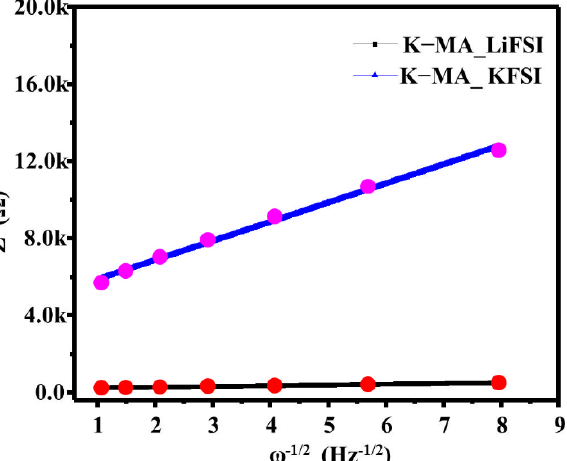
Figure 2. Ion diffusion coefficients of K − MA_KFSI and K − MA_LiFSI in EC/EMC (1:2) as solvent, measured from 1 MHz to 10 mHz, after 200 cycles.